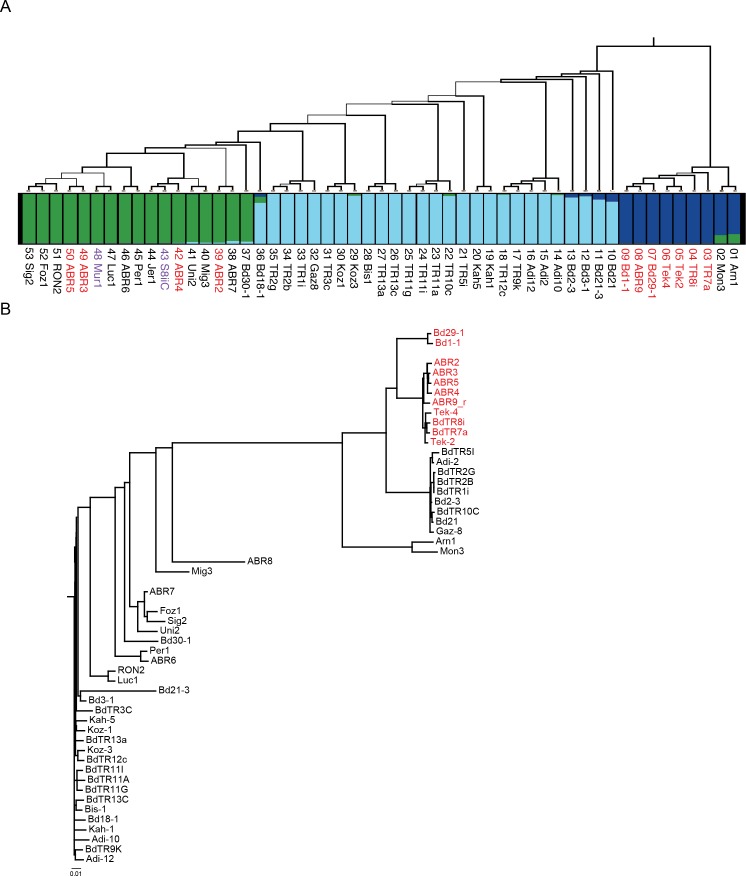
Population analysis.(A) Maximum likelihood phylogenetic tree based on 3,933,264 SNPs spanning the genomes of 53 B. distachyon accessions, modified from (Gordon et al., 2017). Thickness of branches indicates bootstrap support: thick branches, 100%; intermediate, 70–99%; and thin, 50–69%. Red text indicates SD vernalization non-responsive accession, black text indicates SD vernalization responsive accessions, and purple text indicates accessions in which physiological experiments have not yet been conducted. Below the tree is a plot of individual membership (SNP profiles) to optimal K = 3 Bayesian STRUCTURE groups: EDF +miscellaneous (blue), middle eastern (light blue) and western European (green). (B) Phylogenetic analysis based on 940 SNPs spanning a 65 kb mapped interval in which FTL9 resides. Color of text same as (A). Scale bar indicates substitutions per site.